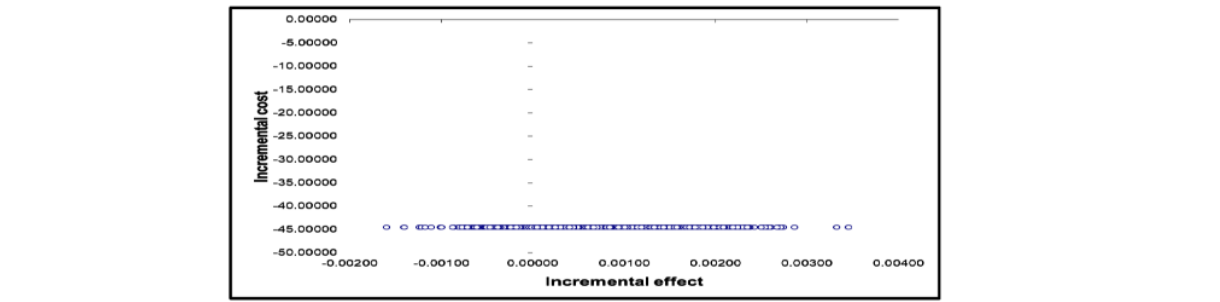
Figure 2. The incremental cost-effectiveness plane for a plot of 1000 bootstrap incremental costs and effects resample means. The blue circles are the plots of 1000 bootstraps incremental costs and effects resample